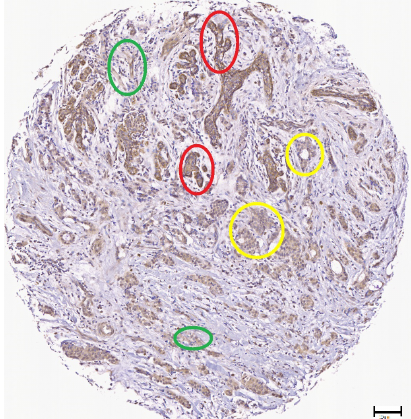
Figure 7. Illustration of stained cases of Wnt-1 : ( a ) heterogeneously; and ( b ) homogeneously, scale bar = 20 µ m.